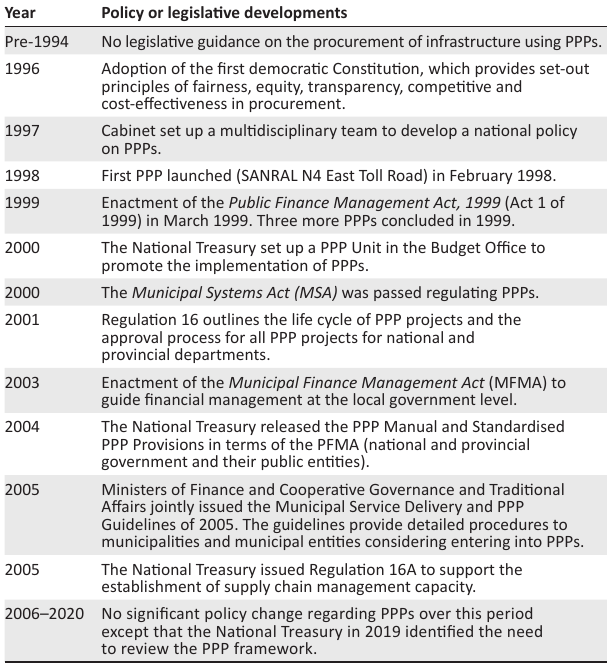
TABLE 1: Legislative developments leading to the formal public–private partnership framework in